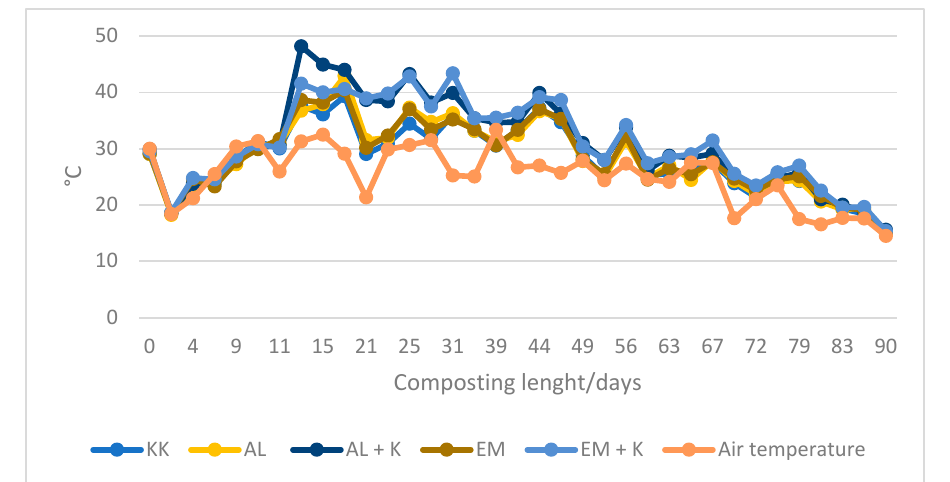
Figure 1. Temperature during the composting process. The reactors were turned every week at the beginning of experiment and every second week at the end. Moisture content of composted mass was tested, to be sure that the value of the parameter was in the range between 55 and 75%. If the value was too low, water was added to the compost. Each variant of compost was mixed and collected before sampling for potting tests. Selected physiochemical parameters and content of elements in composts before potting Table 1. The combinations of compost mass in reactors. medium preparation were examined (Tables 2 and